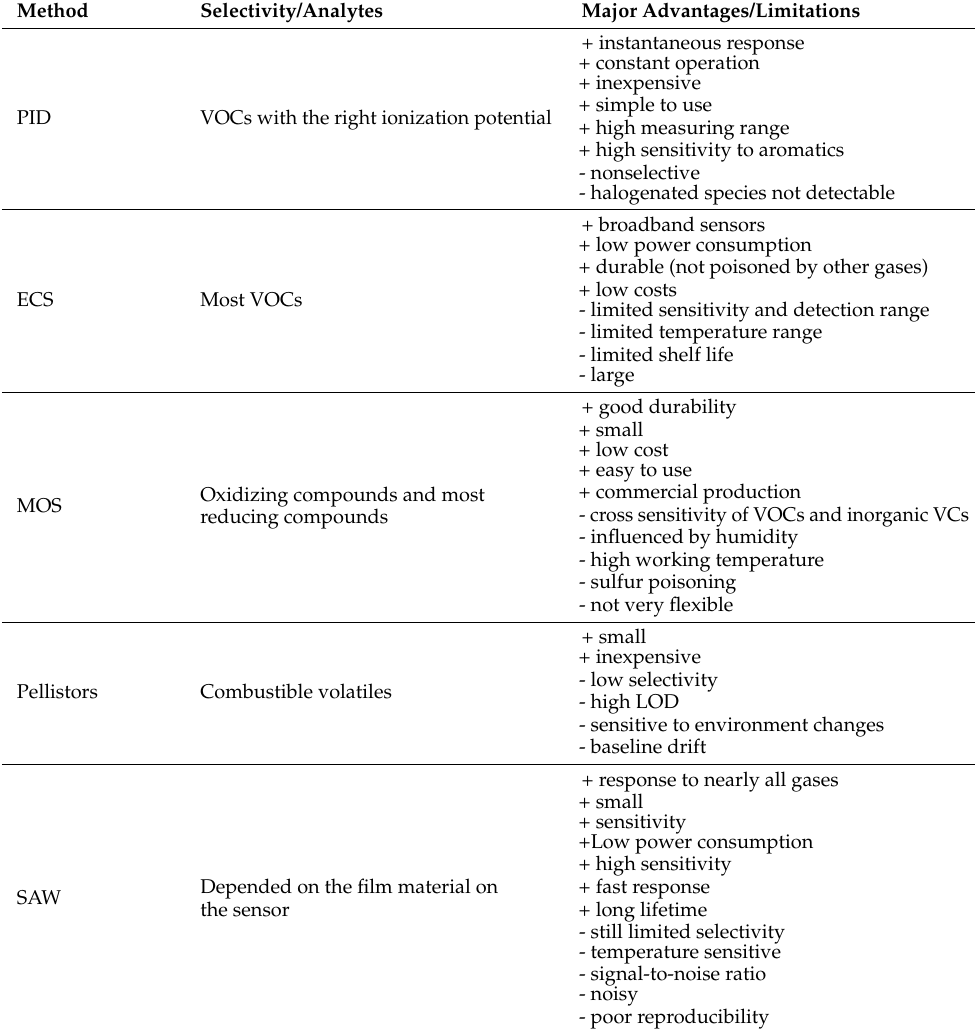
Table 3. Methods described in the article with corresponding suitable analytes and advantages (+) and limitations (-) of them. This list was compiled from all literature references cited in this article and represent the average properties of the methods which may not be true for every single device that belongs to